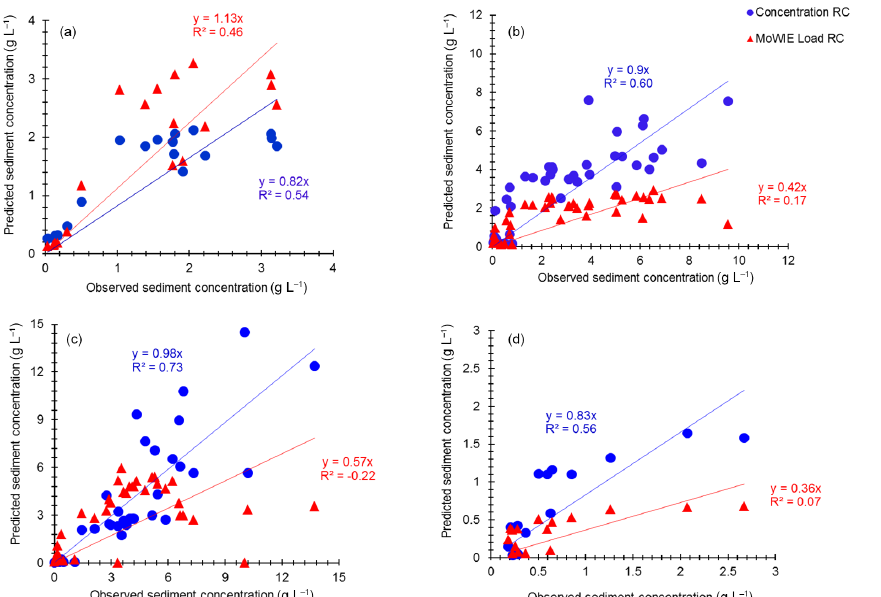
Figure 4. Predicted vs. observed sediment concentration using concentration rating curve and MoWIE load rating curve for the Lake Tana watersheds (a) Gilgel Abay, (b) Gumara, (c) Ribb, (d) Megech.